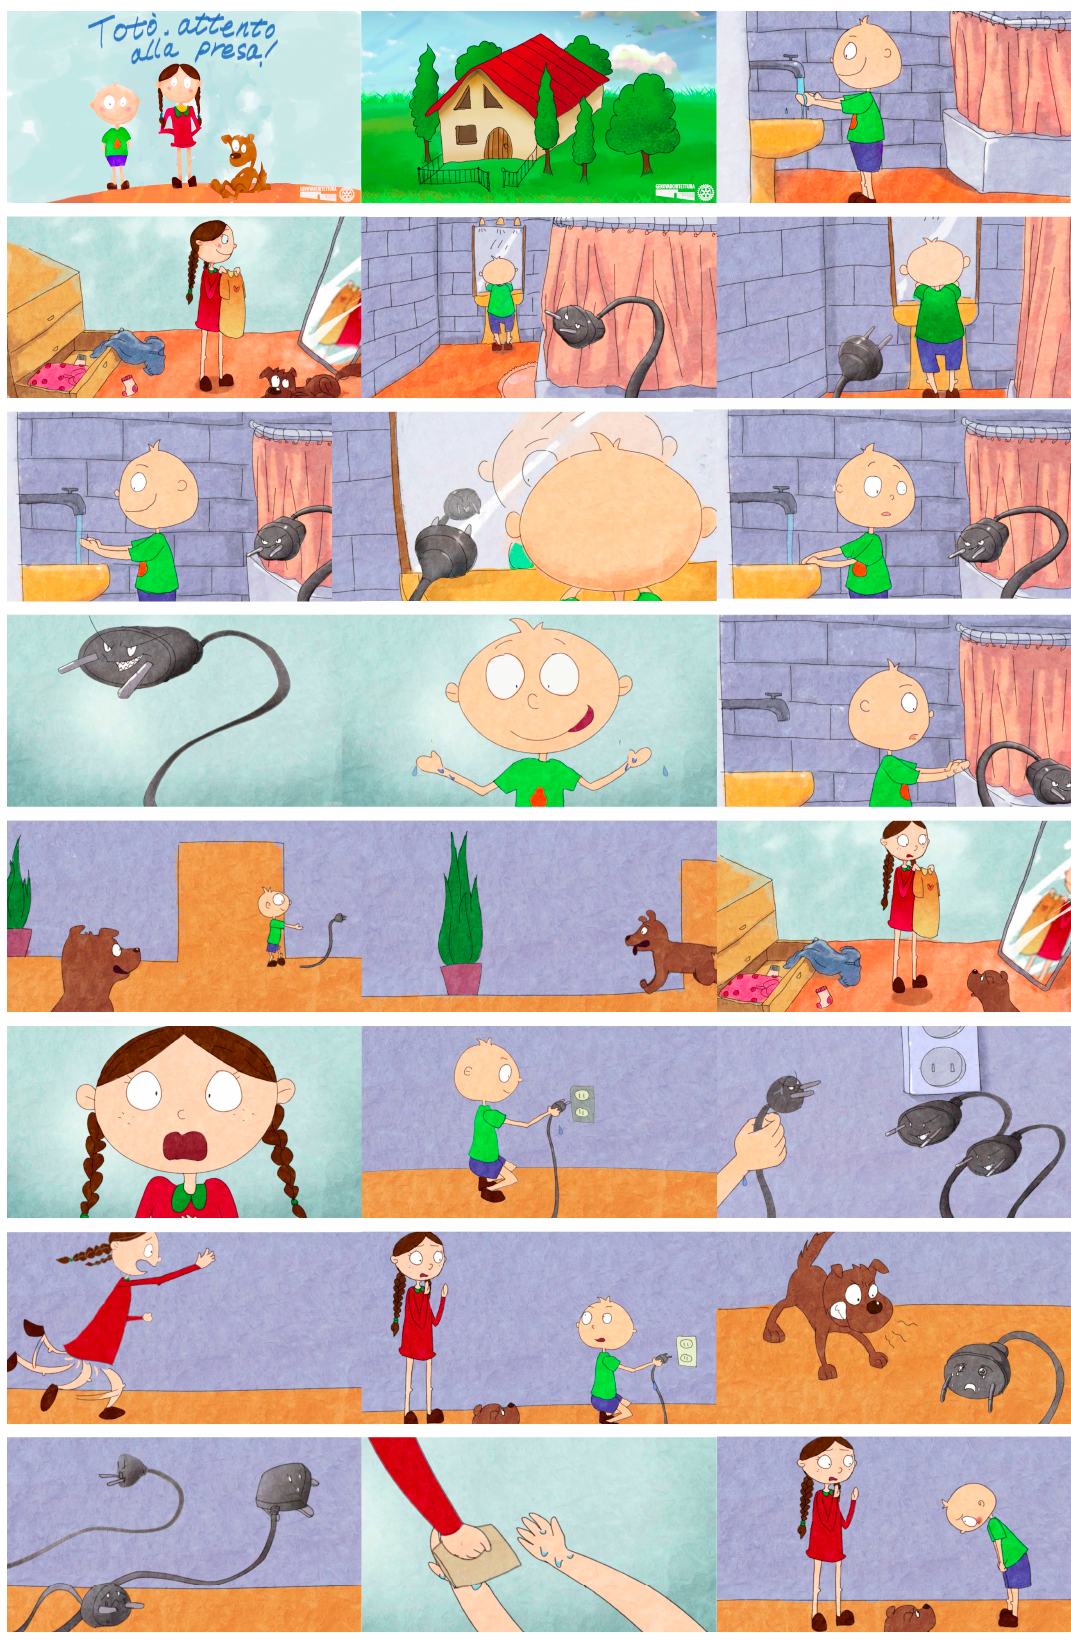
Figure 3. Frames from the project “Totò, attento alla presa”. Problem: “home incident” (improper use of electrical devices). Target: children 6–9 years. Technique: animation; cross cutting, duration 1 min and 30 s. Visual column: images and texts; Soundtrack: music. Authors: A. Blasco, Z. Qi, X. Qinyue. Credits in note 3